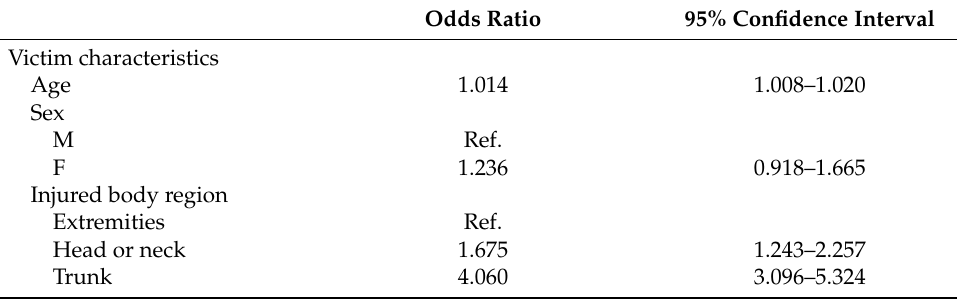
Table 4. Odds ratios and 95% confidence intervals for factors that affected severe